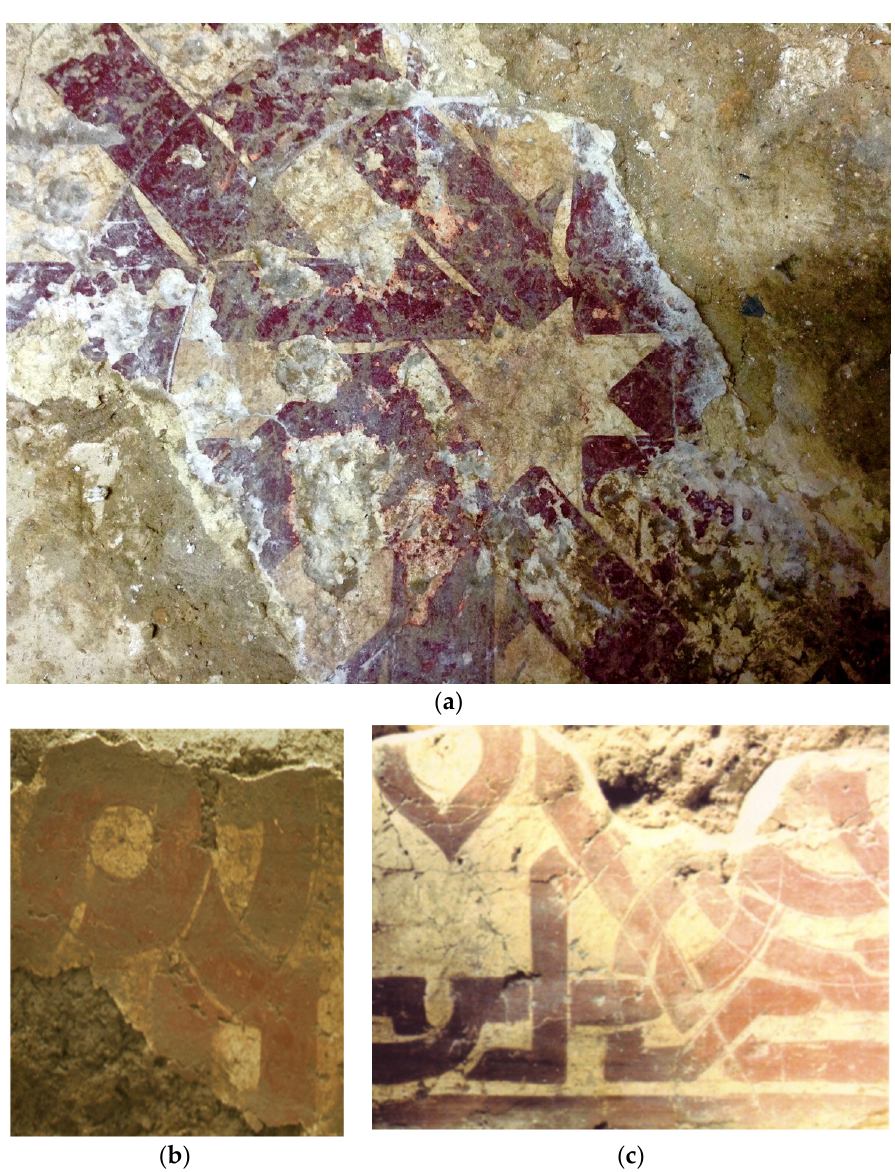
Figure 2. Traces of fresco techniques in the 12th century: ( a ) Plaza de San Pedro, Huelva (Miguel Ángel López in Díaz (Huelva Magazine 2018)); ( b ) Antonio Maura Street, Córdoba (Moreno 2004); ( c ) Palacio de Orive, Córdoba (Murillo et al. 1992).